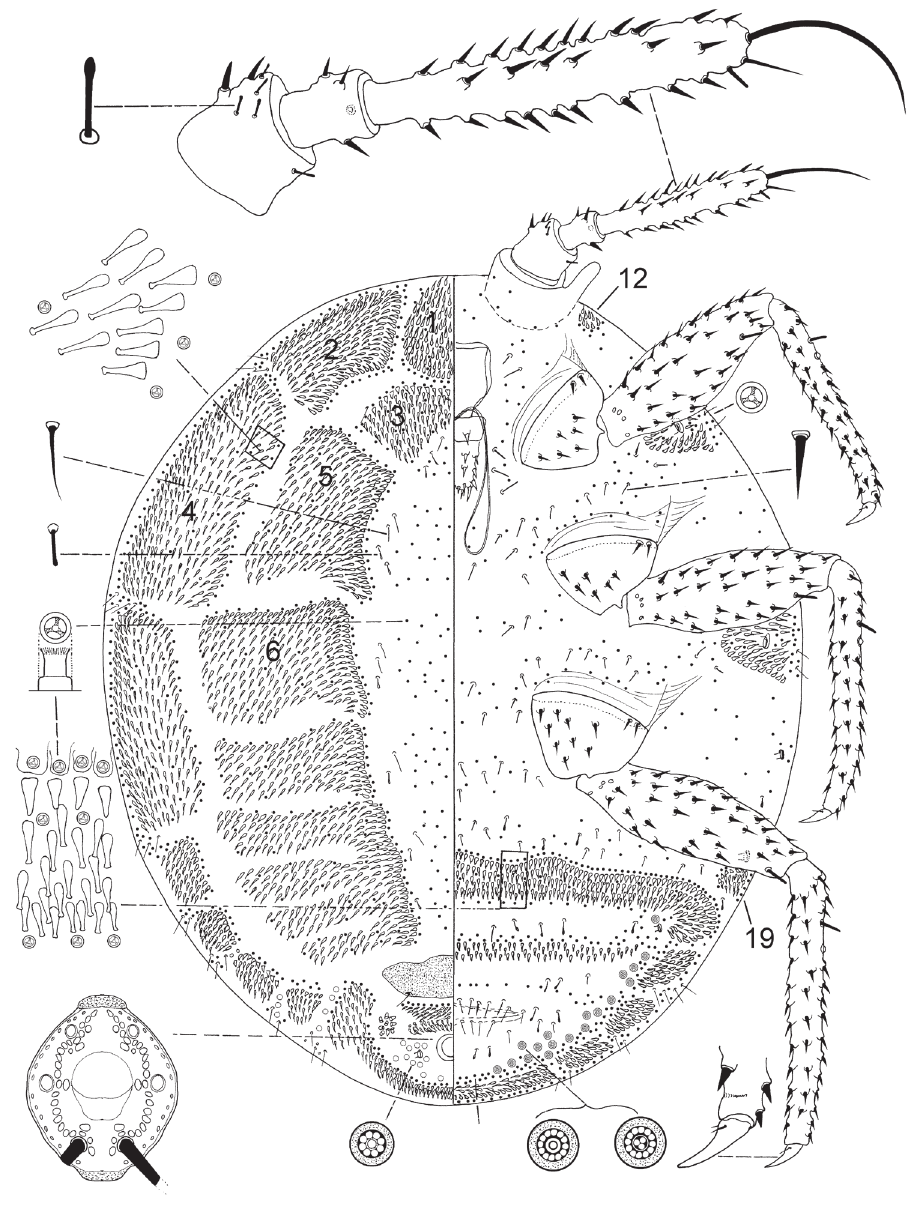
Figure 1. Ortheziola hauseri Konczné Benedicty & Kaydan sp. n., holotype, adult